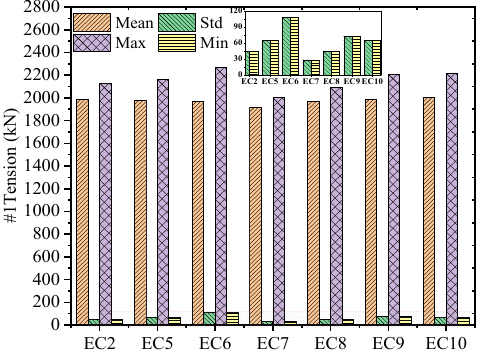
Figure 12. Statistics of the #1 tension.